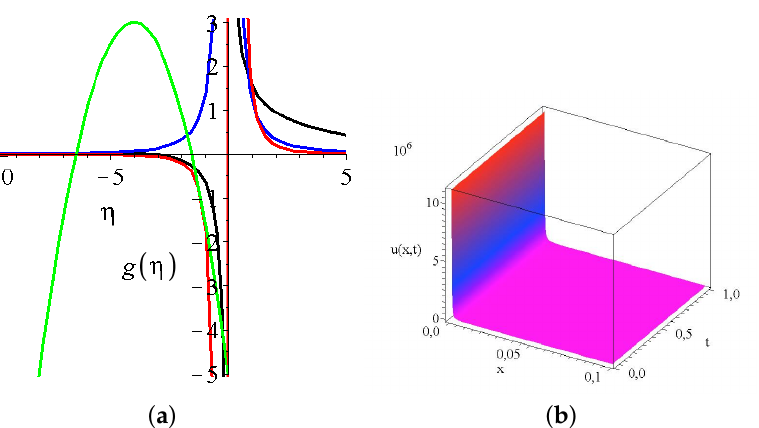
Figure 3. The shape function and the solution for the x component of the velocity. ( a ) The shape function of the x velocity component g ( η ) for four different α exponents for the constant seabed function. The black, blue, red and green line correspond to 1,2,3 and − 2 values, respectively. The integral constants c 1 = c 2 = c 3 = 1 and d = − 1. ( b ) The velocity projection u ( x , y = 0, t ) = t − γ g ( η ) ; for γ = 2, other integration constants and the water depth remain the